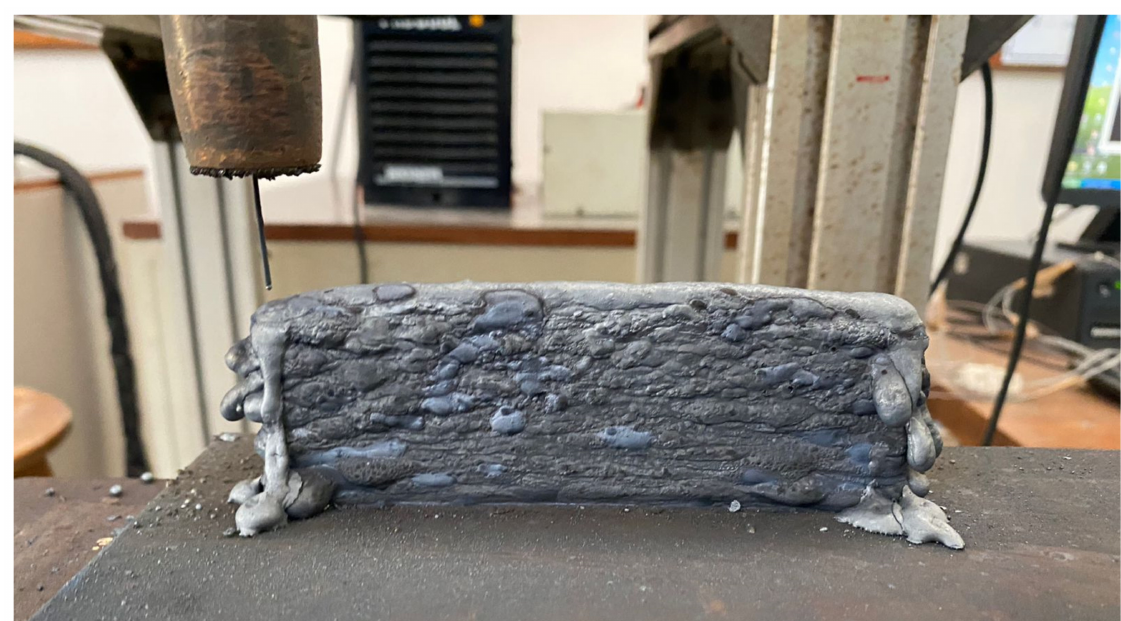
Figure 10. Multi-layer structure obtained at optimized